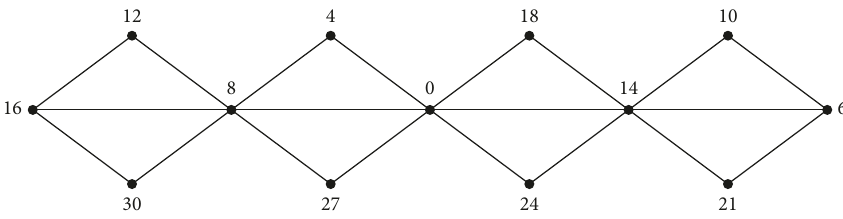
Figure 2: The radio number of double triangular Δ